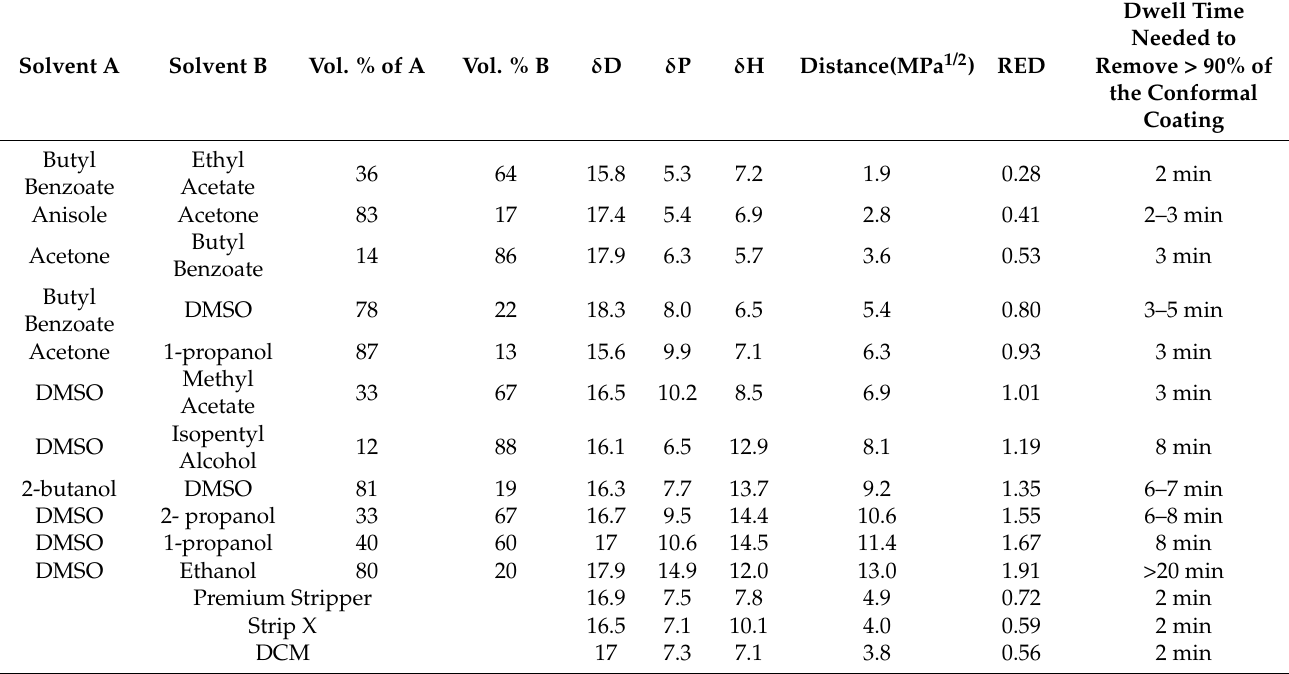
Table 2. Dwell time of selected solvent blends (n ≥